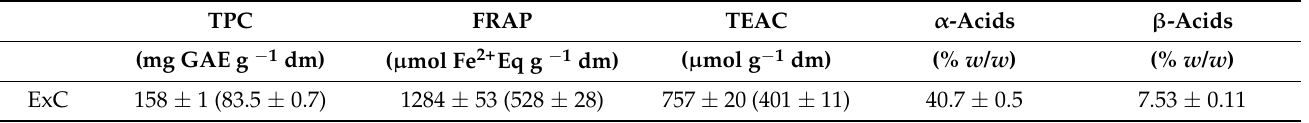
Table 1. Characterization of concentrated hop extract.